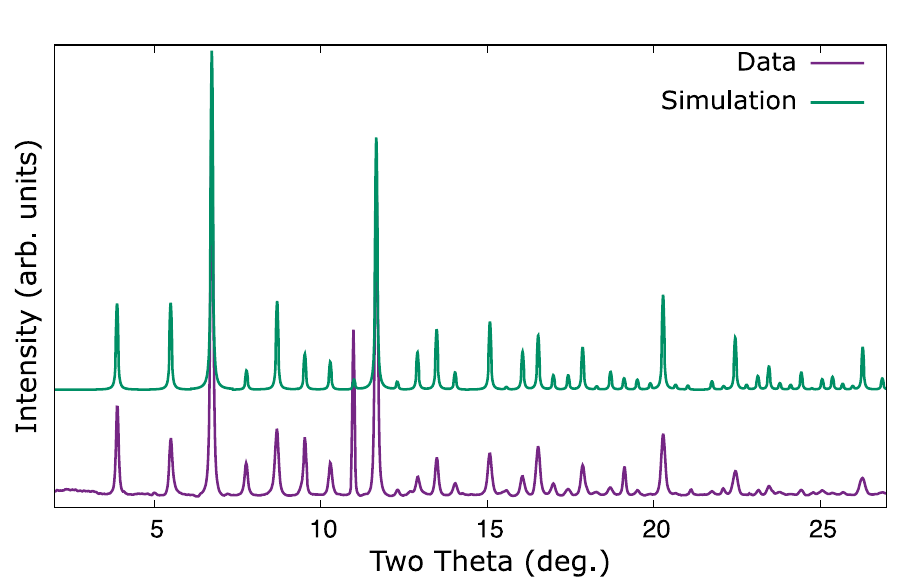
Figure 9. Comparison of observed data from a lithium–palladium–hydrogen mixture at 9.74 GPa (lower ¯ 43 m Li trace) and a simulated powder pattern (upper trace) of I 11 Pd 2 using the atomic parameters from Li 11 Pt 2 14 and lattice parameter and radiation from this study. The similarity supports the palladium–lithium–hydrogen compound having a similar structure to Li 11 Pt 2